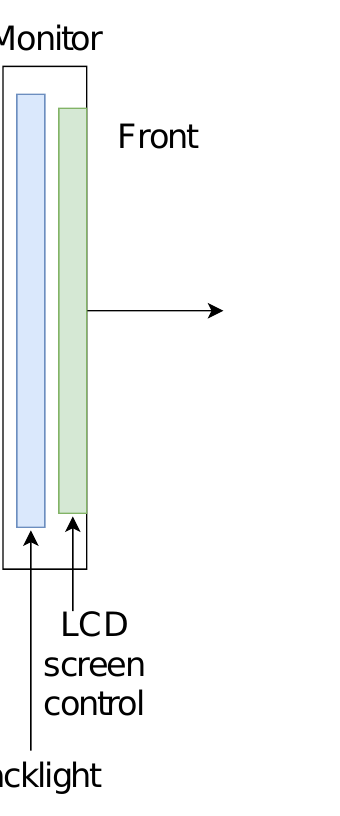
Figure 3. Construction of the LCD monitor (cross-section on the side): transmission method with the use of LCD matrix modulation transmittance modulation ( left ) and using backlight modula- tion ( right